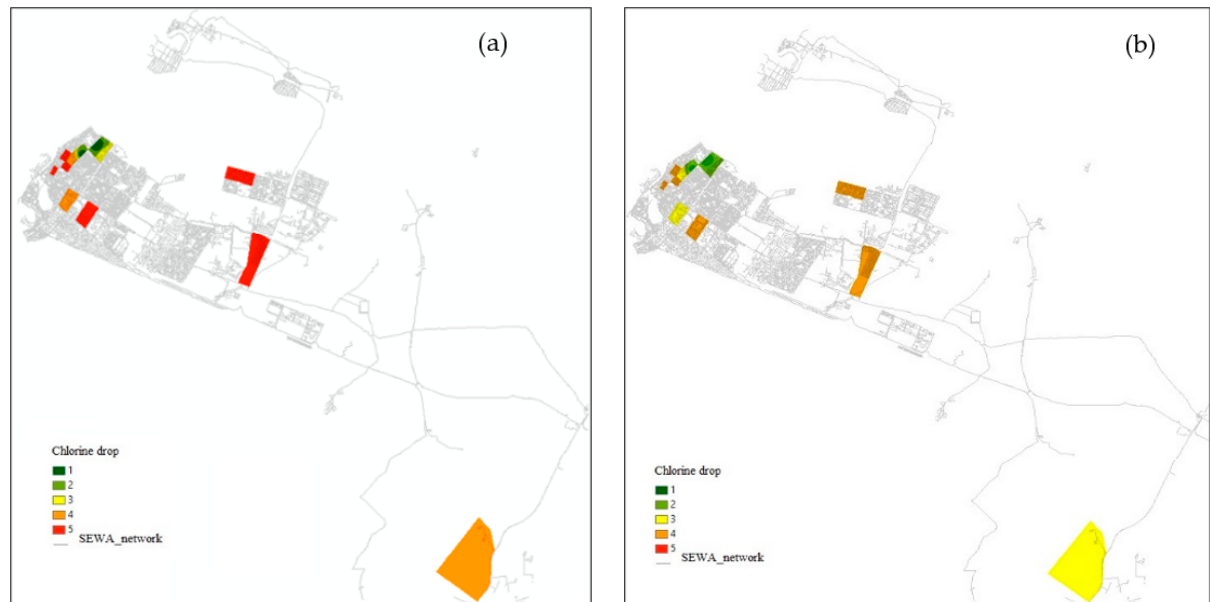
Figure 8. Chlorine drops maps. ( a ) Highest chlorine drop; ( b ) lowest chlorine drop.